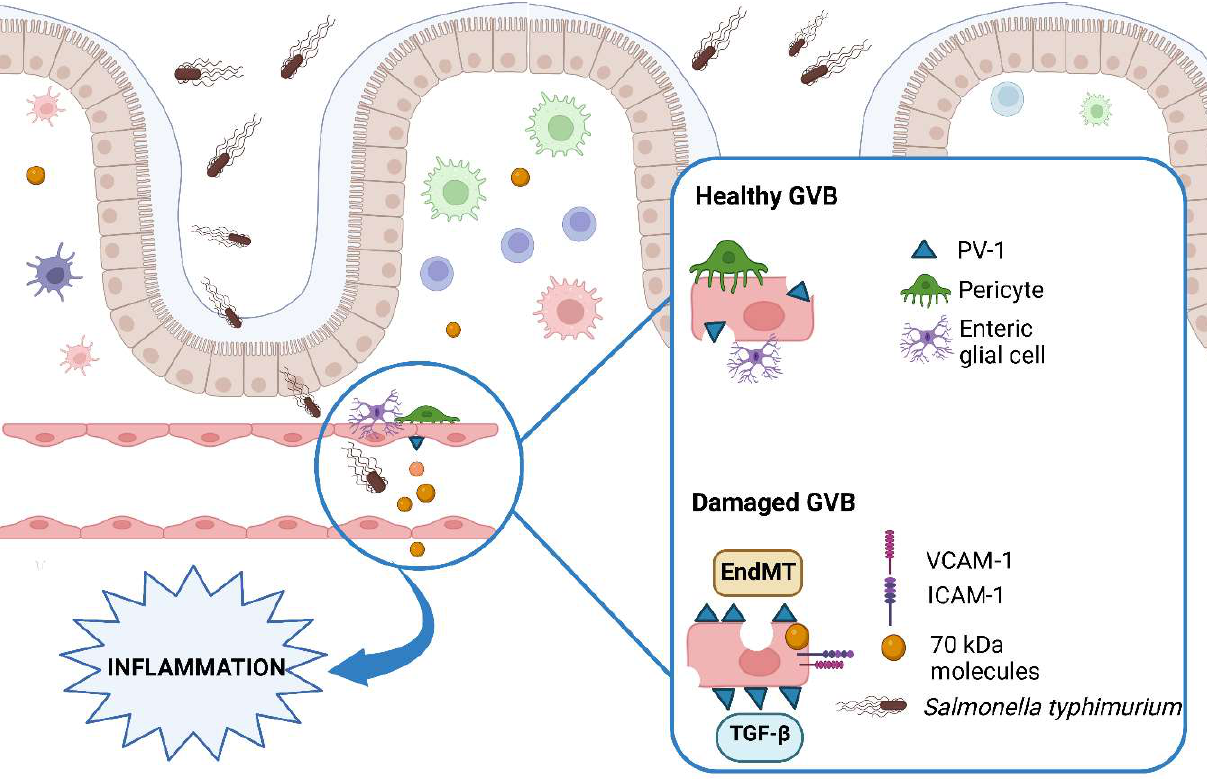
Figure 1. Gut–vascular barrier structure in health and inflammatory conditions. The GVB unit is composed of ECs surrounded by pericytes and enteric glial cells. ECs host small fenestrations, the permeability of which is regulated by the PV-1 protein and express adhesion molecules (VCAM-1, ICAM-1), participating in the inflammatory process. In the case of mucosal damage, as occurs during Salmonella infection, gut endothelial permeability is increased and the passage of larger molecules is permitted. EndMT and TGF- β signaling seem to be involved in this process. Thus, increased EC permeability represents a trigger for gut and systemic inflammation. Abbreviations: GVB: gut– vascular barrier; ECs: endothelial cells; PV-1: Plasmalemma vesicle-associated protein-1; VCAM-1: Vascular cell adhesion molecule 1; ICAM-1: Intercellular adhesion molecule 1; EndMT: endothelial to mesenchymal transition; TGF- β : Transforming growth factor beta. Created with BioRender.com.